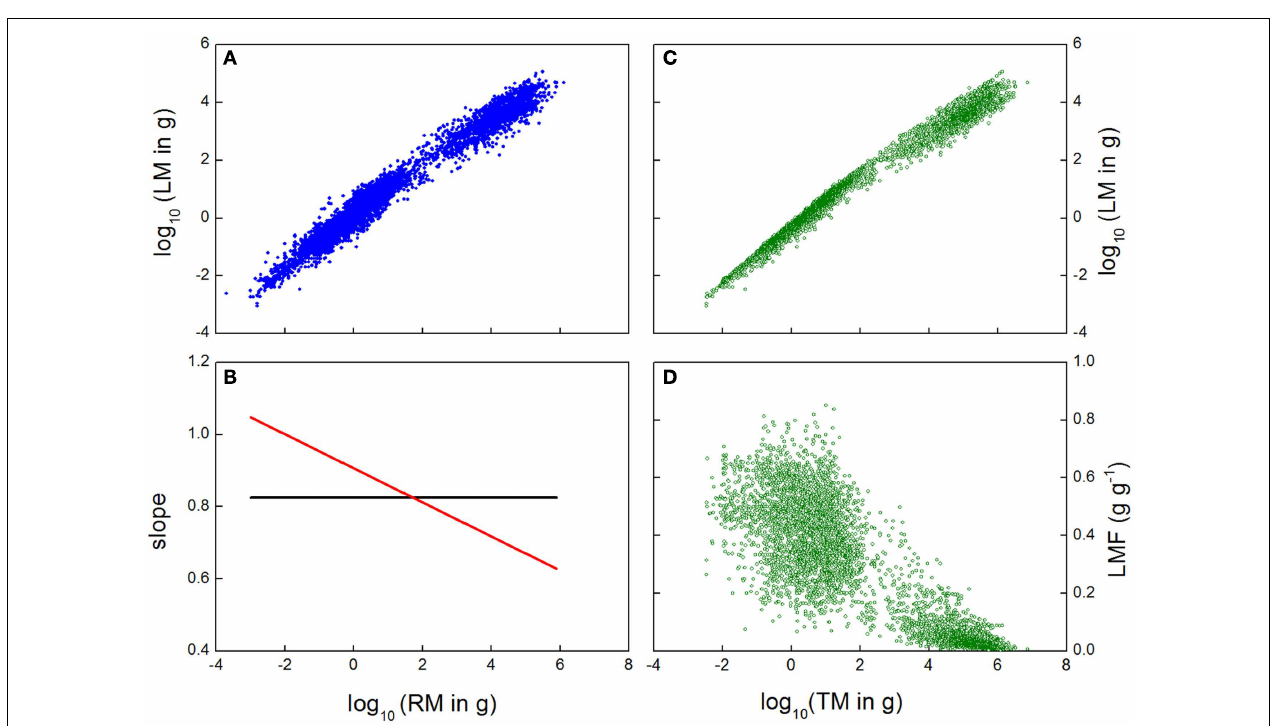
log-transformed total plant mass (TM), and (D) Leaf Mass Fraction (LMF) plotted against log-transformed total plant mass for the same observations. Data are from Poorter et al. (2012), and comprise a large dataset ( n = ∼ 5230) of leaves, stems, and roots of herbaceous and woody